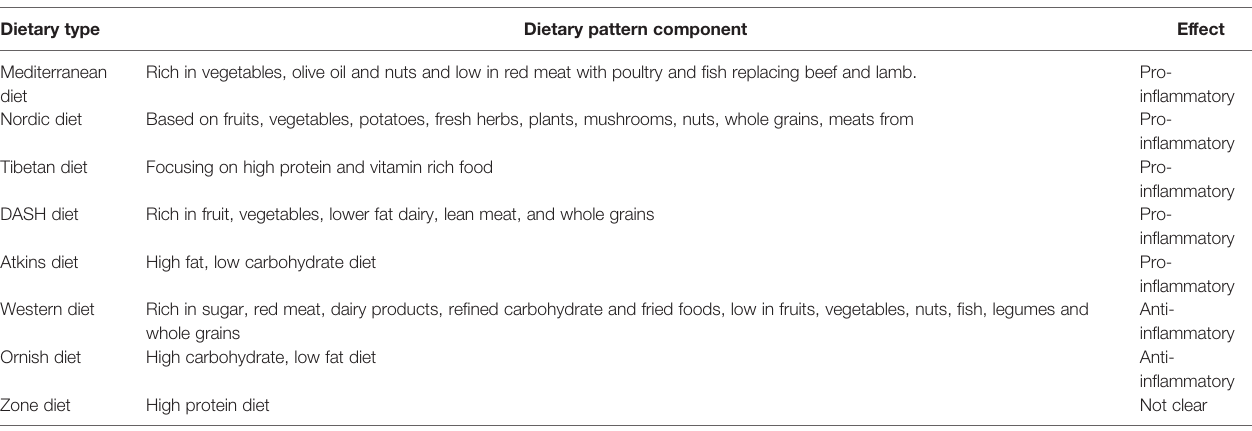
TABLE 4 | Effects of normal dietary patterns on in fl ammation. Dietary type